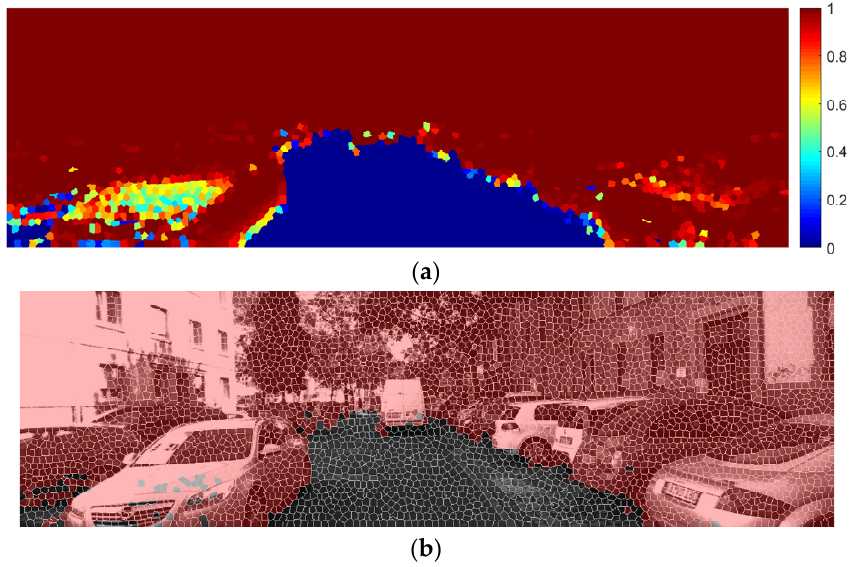
Figure 9. The probabilistic distribution of PR LSF and classification result of OD-LSF method: ( a ) PR LSF probability distribution; ( b ) OD-LSF method classification result.